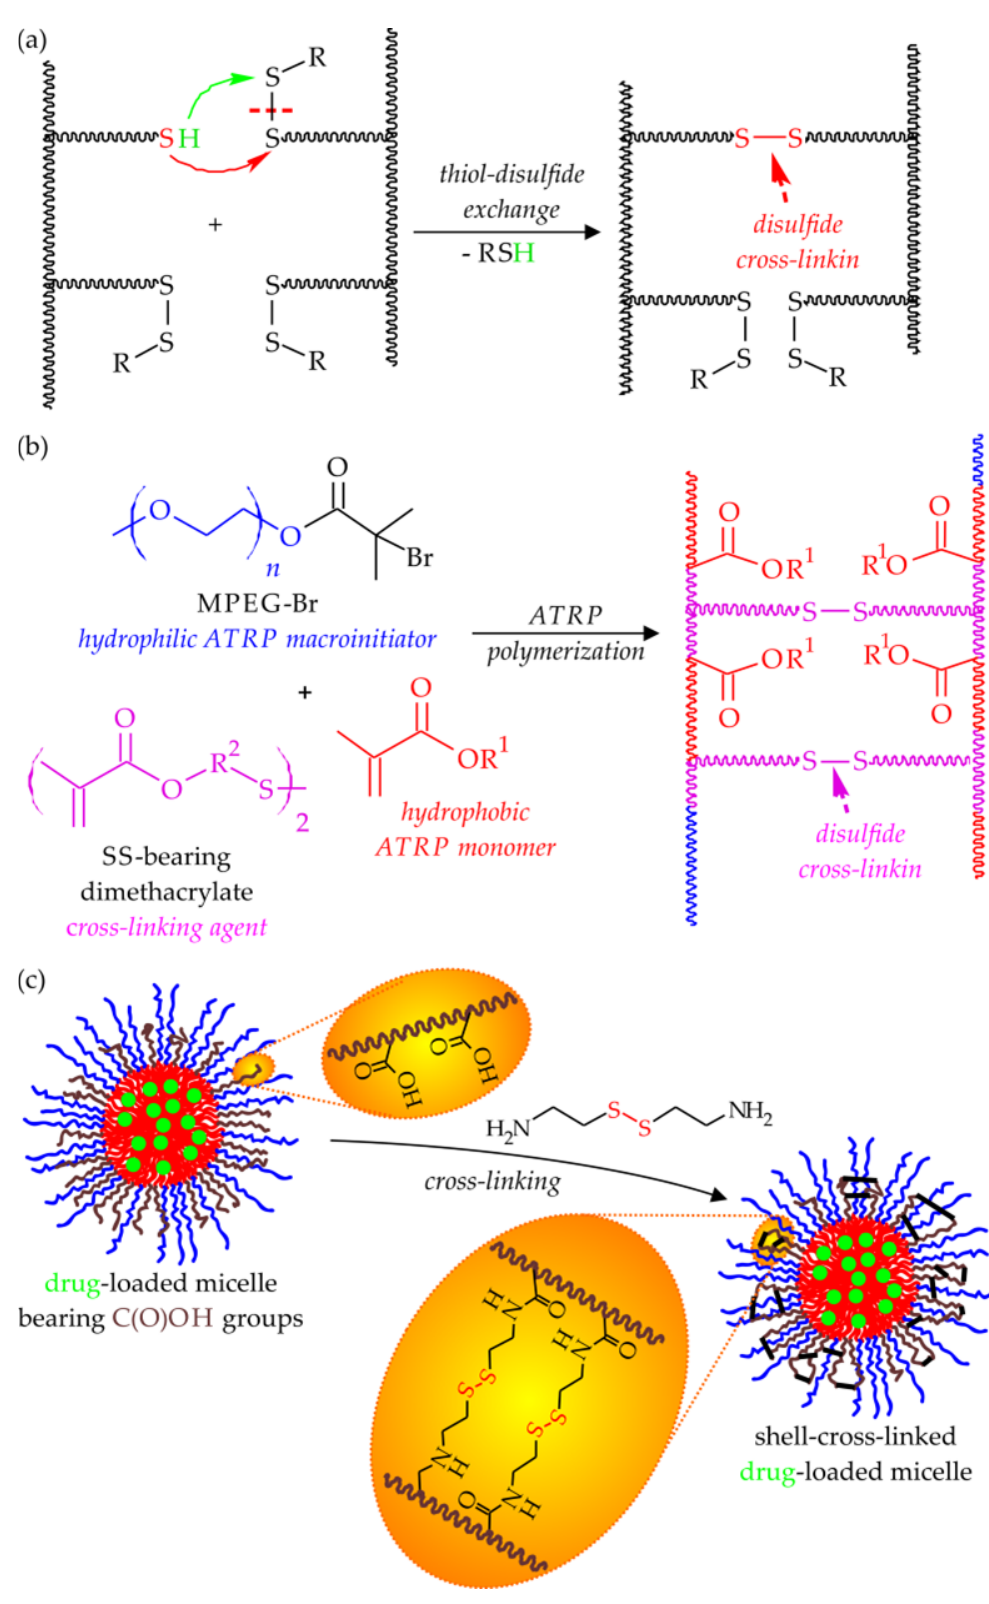
Figure 9. Different synthetic strategies of the SS-based chemical cross-linking of the micellar DDSs: ( a ) reductive cross-linking of the pendant SS-bearing groups, ( b ) cross-linking via a direct ATRP (co)polymerization, ( c ) cross-linking via a post-polymerization modification.